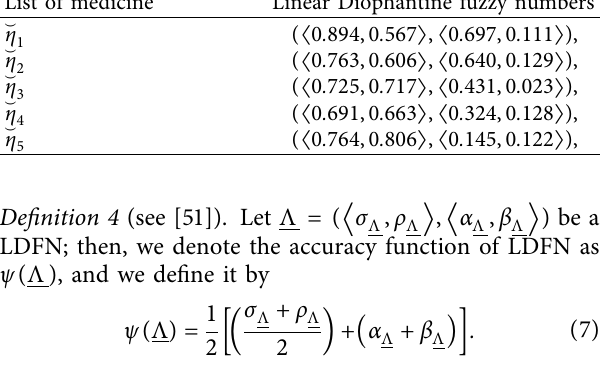
Table 2: Information system for reimbursement of expenses. List of medicine Linear Diophantine fuzzy